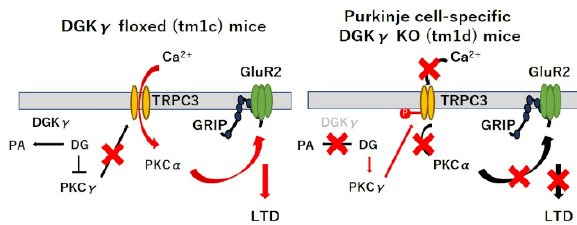
Figure 5. The proposed model of the function of DGK γ in the regulation of PKC γ .